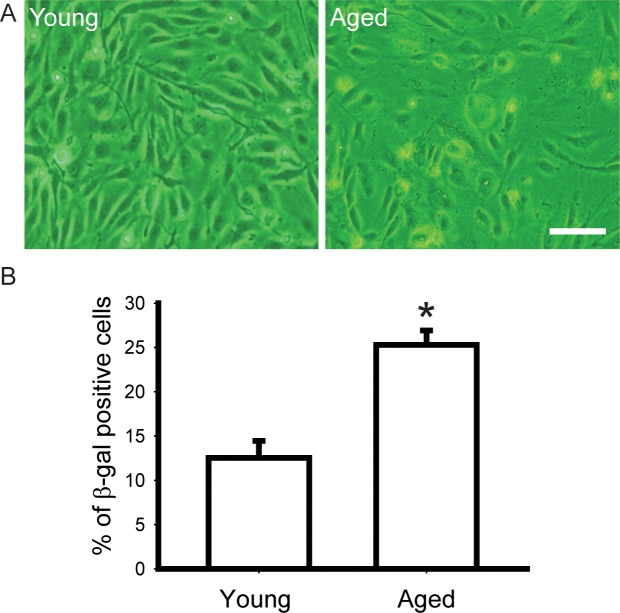
Isolation and aging of CD34+ EPC.Isolated CD34+ EPC were subcultured in vitro and signs of senescence showed after around 10 passages. Replicative senescence resulted in (A) morphological changes (Bar = 10μm), (B) up-regulation of senescence marker (P < .01).